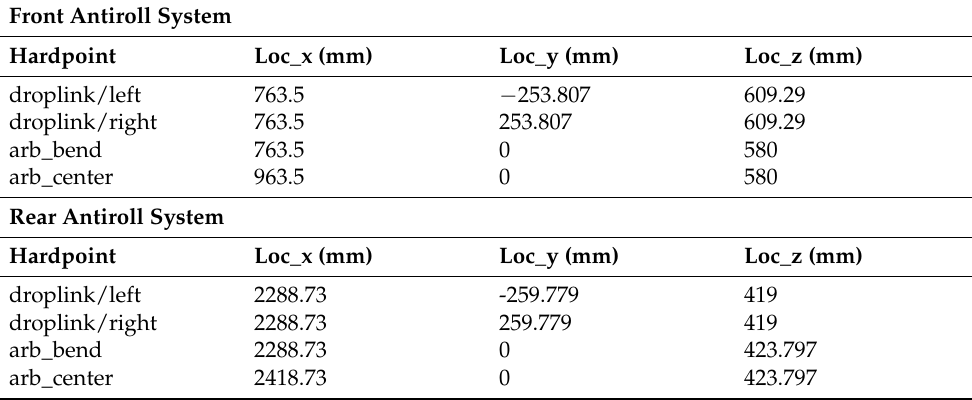
Figure A3. Details of the front/rear antiroll system. Table A4. Hardpoint locations of the rear/left antiroll bar system expressed in the model global reference